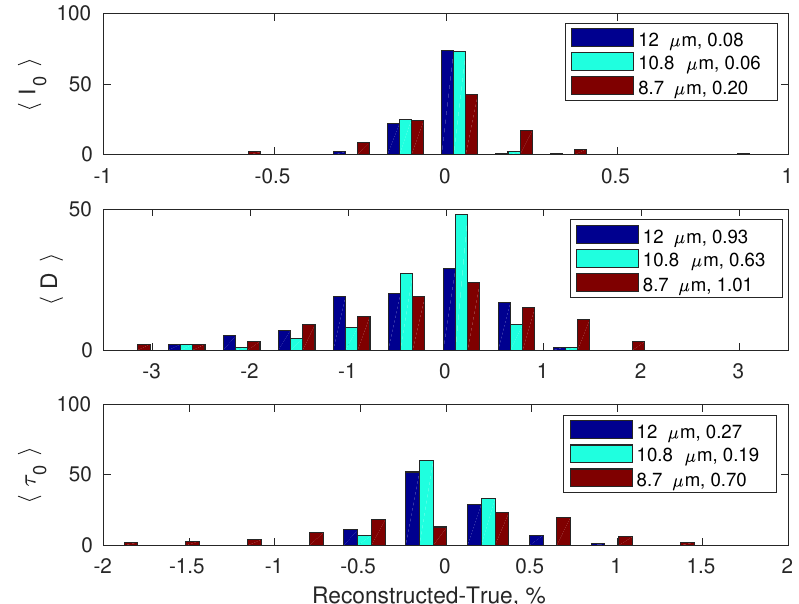
Figure 2. Residuals distribution (reconstructed-true) in percentage units for the three quantities (cid:104) I 0 (cid:105) (upper panel), (cid:104) D (cid:105) (middle panel) and (cid:104) τ 0 (cid:105) (lower panel), for the three SEVIRI channels. The numbers in the legends show percentage root mean squared differences.